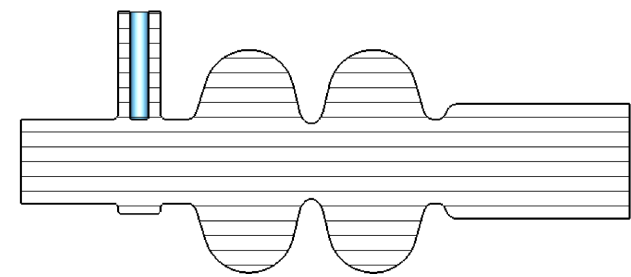
FIG. 7. (Color) Accelerating cavity with 1 cm symmetrizing stub.